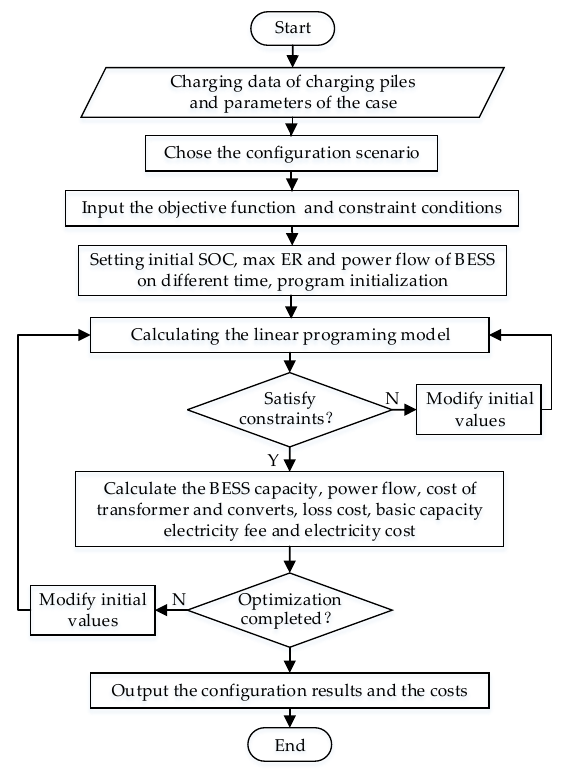
Figure 4. BESS configuration algorithm process of a PEB fast charging station.